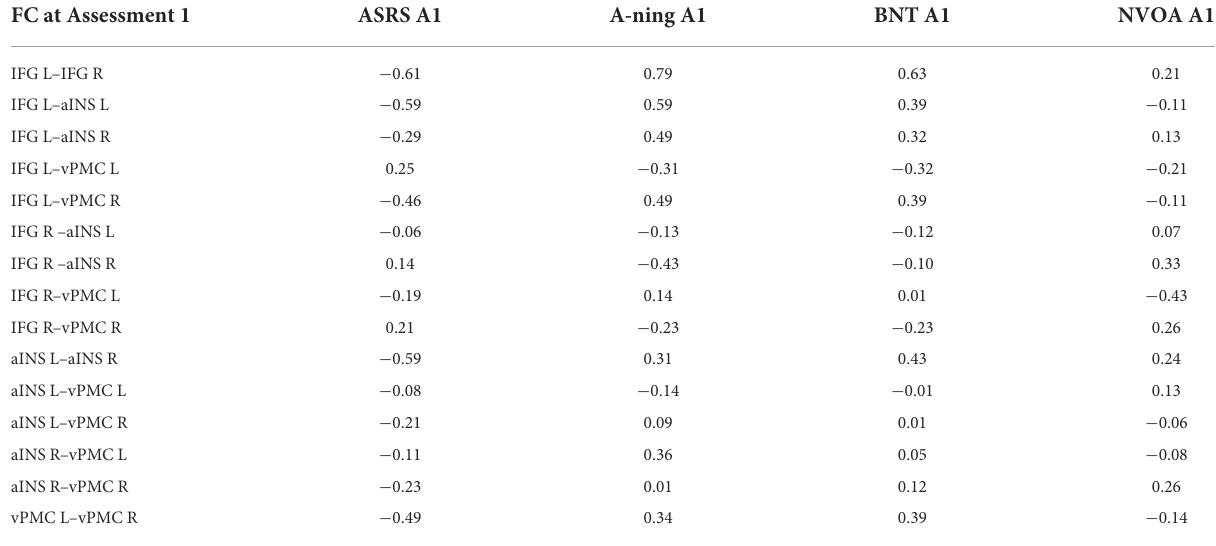
TABLE 7 Relation between FC and behavioral results at the first assessment (A1).